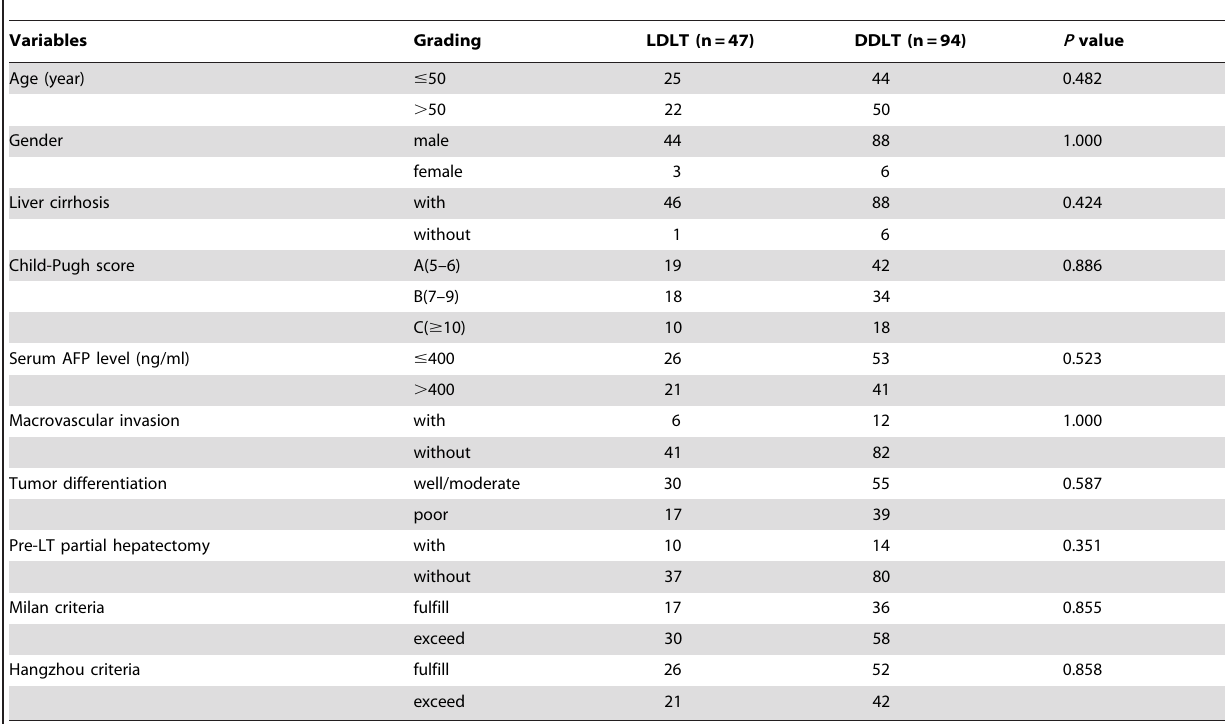
Table 1. Baseline characteristics of patients before transplantation (Chi-Square Tests).